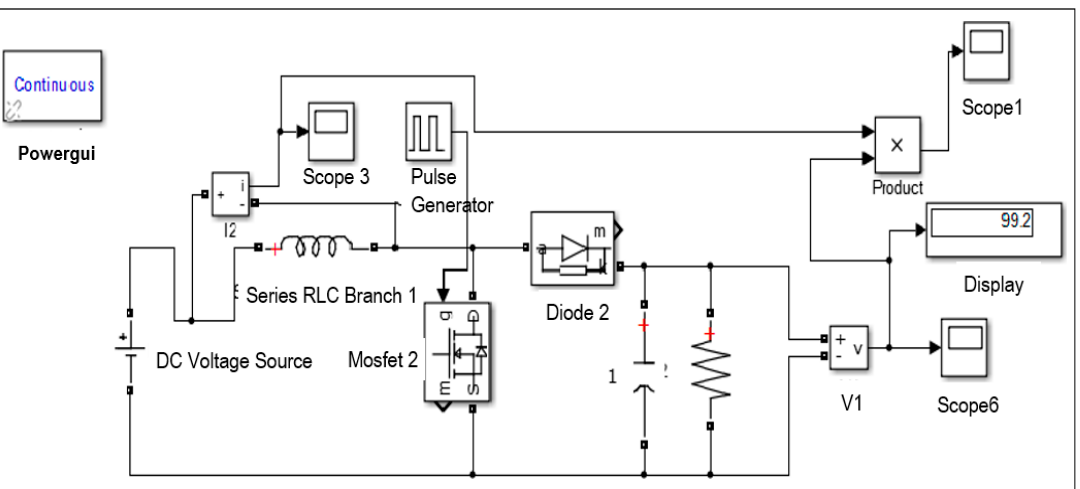
Figure 9. Boost converter model in Simulink-Matlab software. Table 4. Parameters of battery.